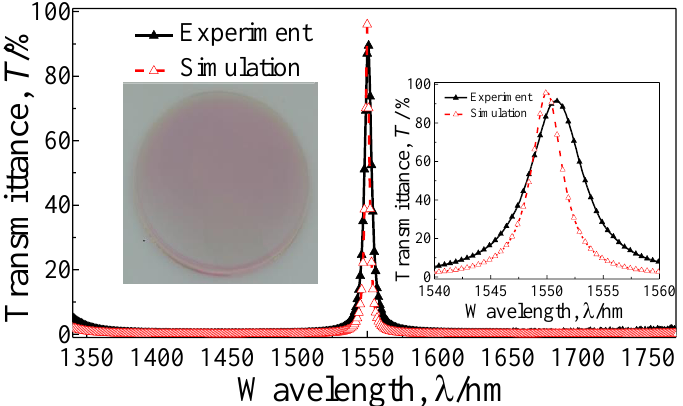
Figure 4. Comparative analysis of the measured and simulated transmittance ( T ). The insets show the fabricated quasi-one-dimensional PC-based NBF picture and the detailed enlarged drawing of the spectra.